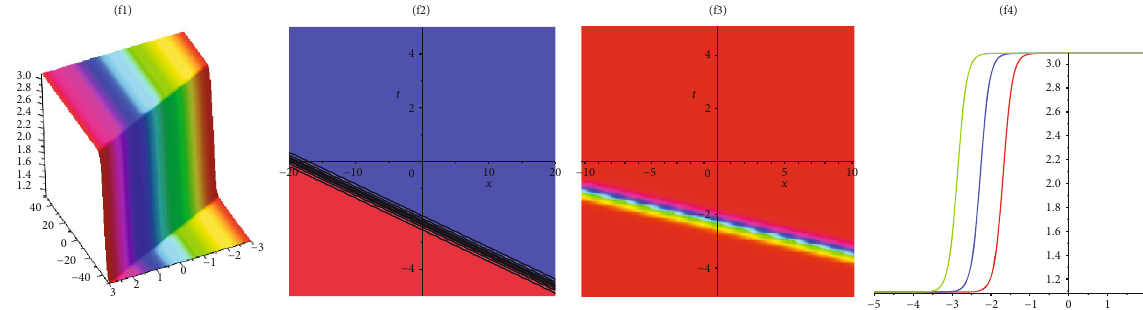
Figure 1: The one-wave solution (15) at α